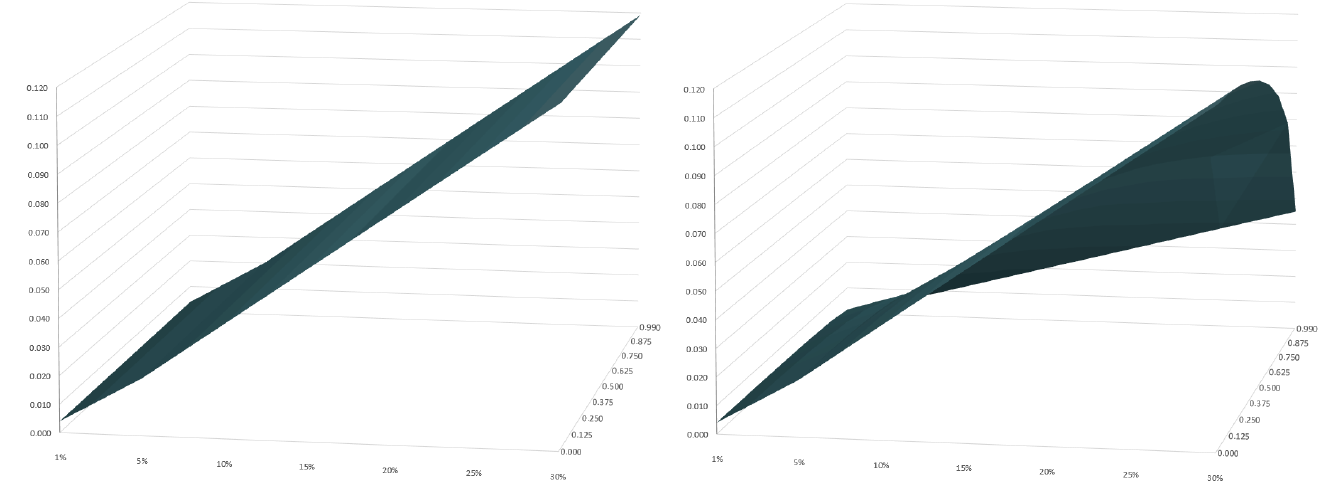
Figure 6. Surfaces of European ATM call (or put) prices ( z -axis) in the reference frames L ( left figure ) and L (cid:48) ( right figure ), for velocities ranging from 0.0% c to 99% c ( y -axis) and the volatilities σ ( x -axis) of 1%, 5%, 10%, 15%, 20%, 25% and 30%, for maturity T = 1 year. For simplicity, we consider values at inception t = 0, r = 0% and both asset prices at inception and strike equal to one S = K = 1.